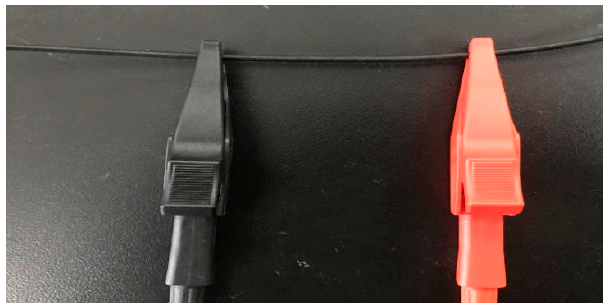
Figure 3. Measurement of the resistance of conductive ABS filaments.